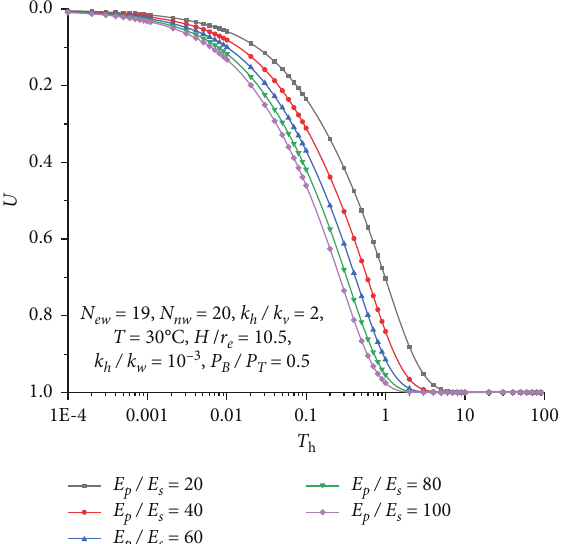
Figure 4: Consolidation curves for different distributions of initial pore pressure.